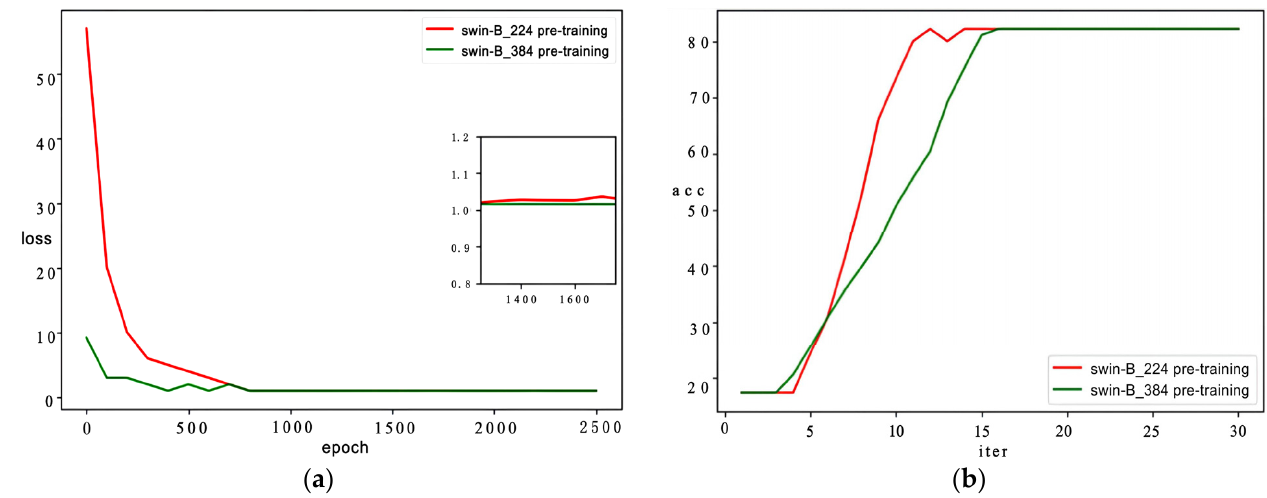
Figure 5. Comparison of loss and accuracy for different models in pre-training. ( a ) Loss for pre- training; ( b ) Accuracy for pre-training.